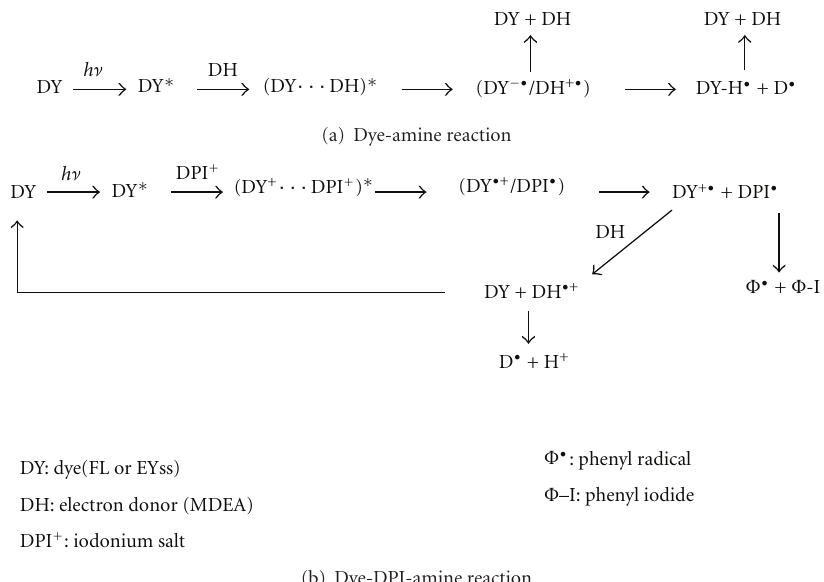
Figure 7: Schematic representation of the reaction mechanism for three-component photoinitiator systems containing FL or EYss, MDEA, and DPI. (a) photoreduction of the FL or EYss dye by MDEA and (b) photooxidation of the FL or EYss dye by